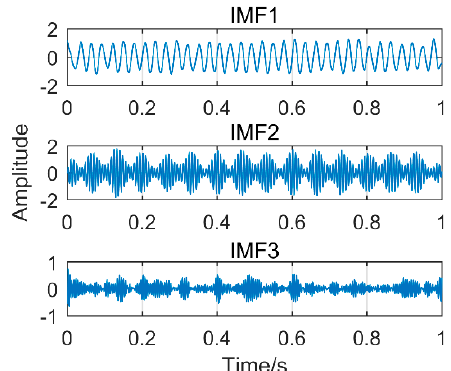
Figure 23. The results decomposition obtained by modified variational mode decomposition .